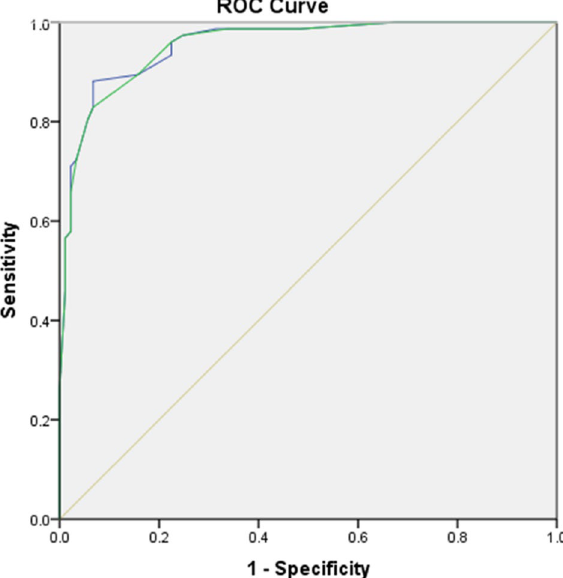
Figure 2. Receiver operator curves for initial and tuned model for prediction of coronary bifurcation stenosis functional significance. Blue line–initial model (AUC = .950, p < .001); green line–tuned model (AUC = .949, p <